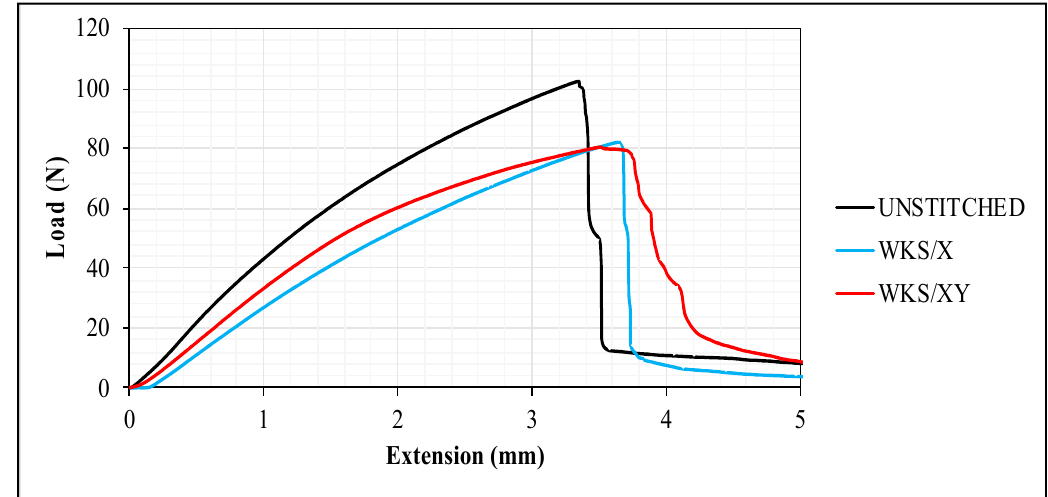
Figure 14. Load versus extension average curves for the unstitched and silk-fiber-stitched woven kenaf composites.